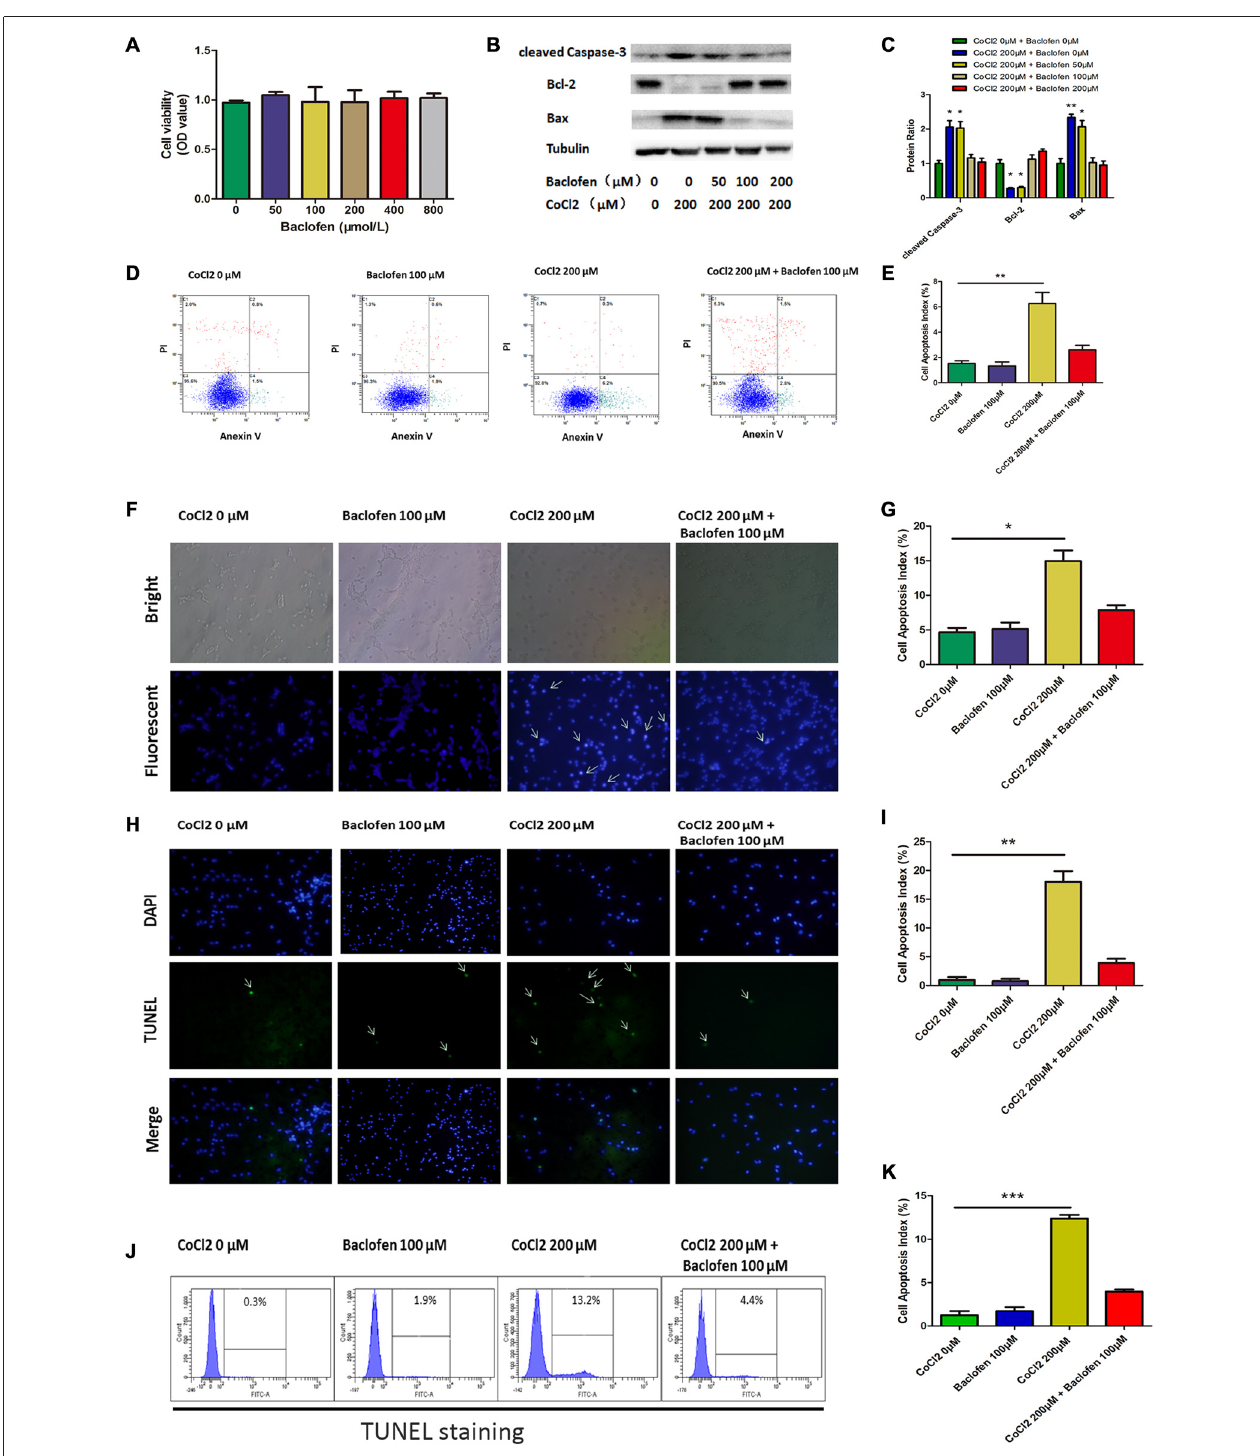
FIGURE 2 | Baclofen protected RGCs against CoCl 2 -induced apoptosis without interfering cell viability of RGCs. (A) Cell viability detected by CCK-8 assay in RGCs treated with indicated concentrations of baclofen for 24 h. Data are means ± SD of three independent experiments. ∗ p < 0.05, ∗∗ p < 0.01 vs. basal level. (B,C) Expression of cleaved caspase-3, bax and bcl-2 detected by Western blotting in RGCs treated with indicated concentrations of CoCl 2 and baclofen for 24 h. The detected protein bands are normalized to the signal of α -tubulin. The protein levels were expressed as the value relative to the control. The data